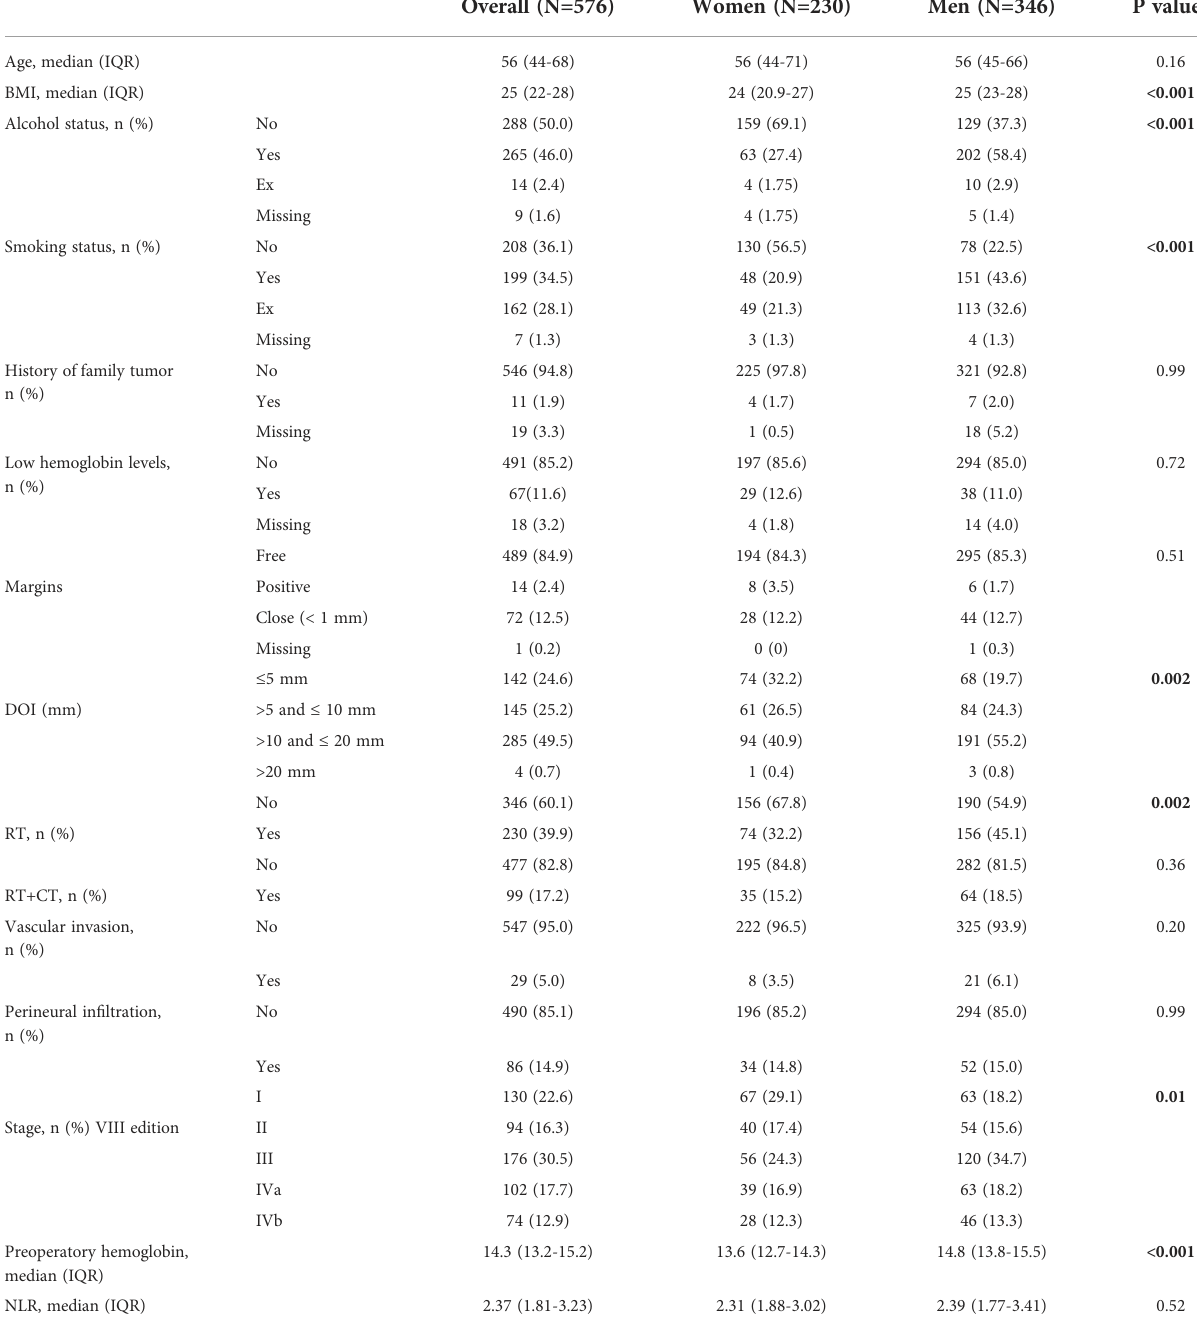
TABLE 1 Patients and tumor characteristics (N=576 patients, 39.9% women and 60.1%